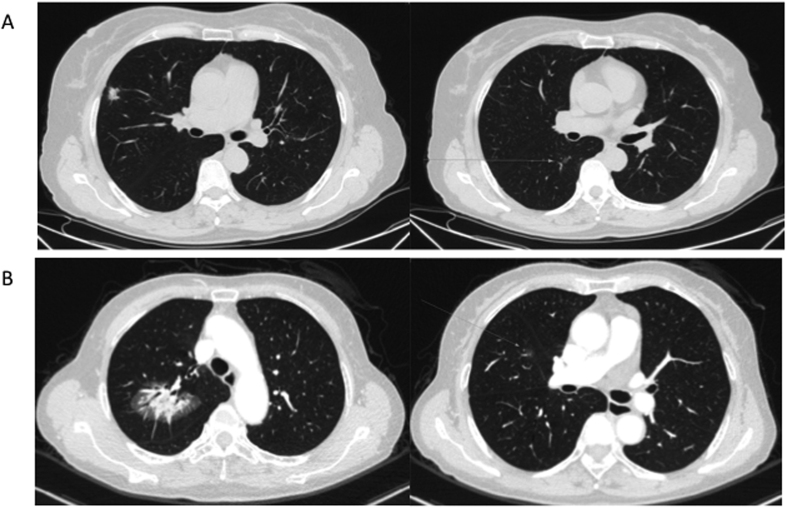
CT scan images for two MPLC patients.(A) Images of Patient I. Left, CT scan of upper right lobi pulmonis; and right, CT scan of lower right lobi pulmonis. (B) Images of Patient II. Left, CT scan of upper right lobi pulmonis; and right, CT scan of middle right lobi pulmonis.